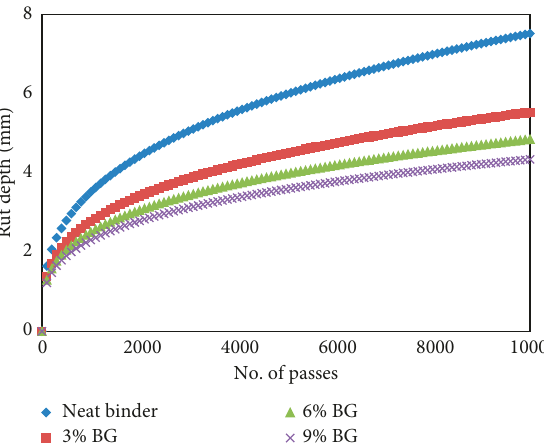
Figure 17: Rut depth graph at 55 °